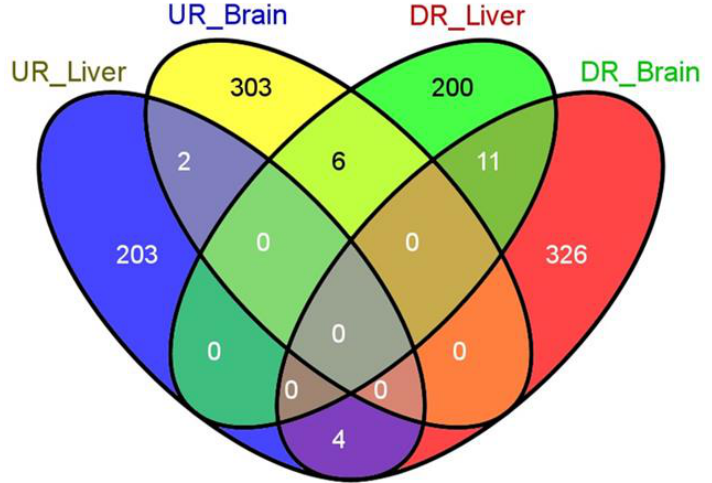
Figure 2. Venn diagram of the differentially expressed genes in the liver and brain after rapid eye movement sleep deprivation for nine days in rats. The Venn diagram shows overlapping genes of the UR_Liver (up-regulated liver); UR_Brain (up-regulated brain); DR_Liver (down-regulated liver); and DR_Brain (down-regulated brain). Numbers in separate shaded panels reflects the genes typically affected in both tissues, in a similar or opposite direction.